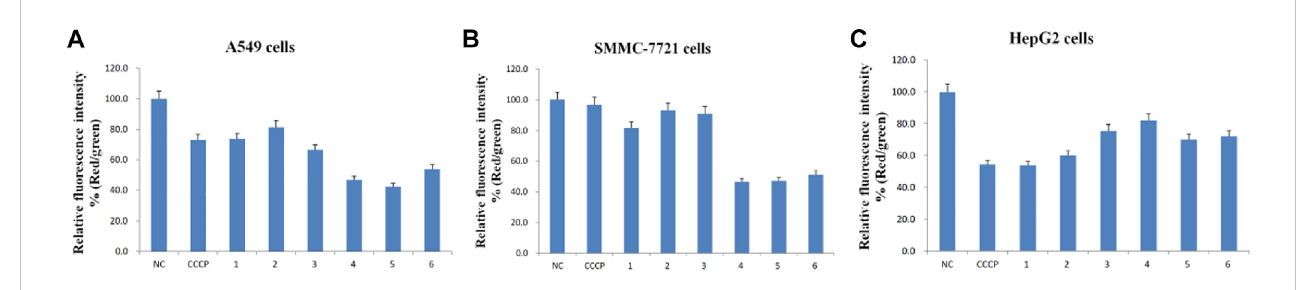
FIGURE 5 Relative fl uorescence intensity (Red/green) of the six puri fi ed saponins in three cancer cell lines (A549, SMMC-7721 and